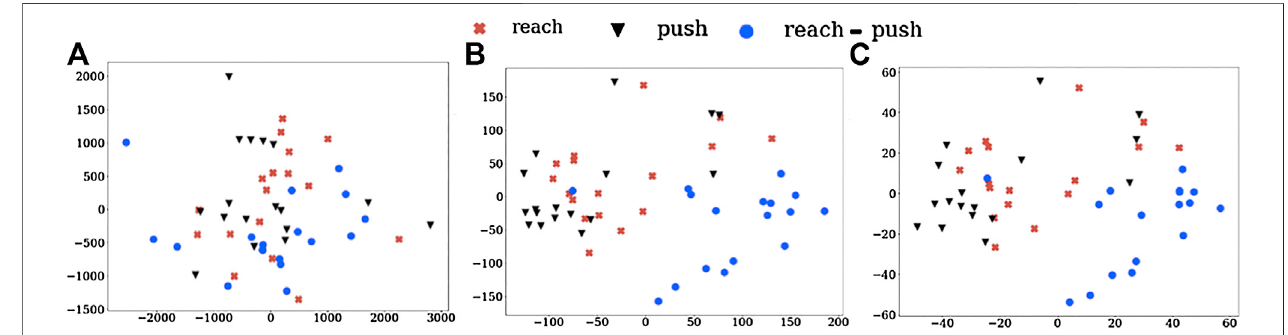
FIGURE 3 | Visualising LMD for (A) Baseline-R and using action vectors from (B) pool5 and (C) fc6 layers of NN:UCF101 model. We can see the clustering of the action vectors into different task classes.